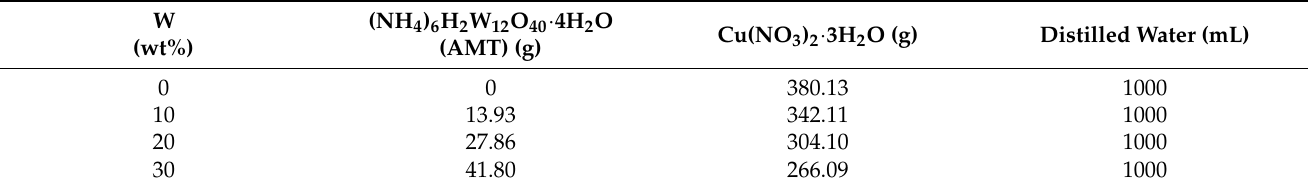
Table 1. Composition of the synthesized Cu-W composite